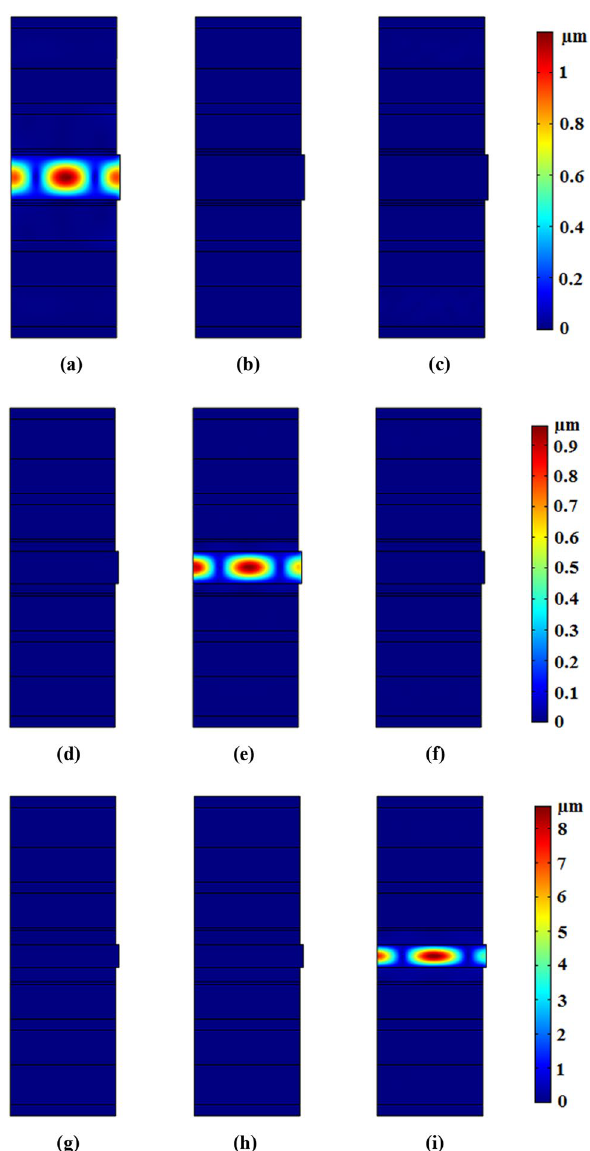
Figure 8. Displacement field on z–x plate in phononic crystal fibers with core radius equals to r 1 and input frequency of ( a ) 25 kHz, ( b ) 31.5 kHz, and ( c ) 40 kHz, with core radius equals to r 2 and input frequency of ( d ) 25 kHz, ( e ) 31.5 kHz, and ( f ) 40 kHz, with core radius equals to r 3 and input frequency of ( g ) 25 kHz, ( h ) 31.5 kHz, and ( i ) 40